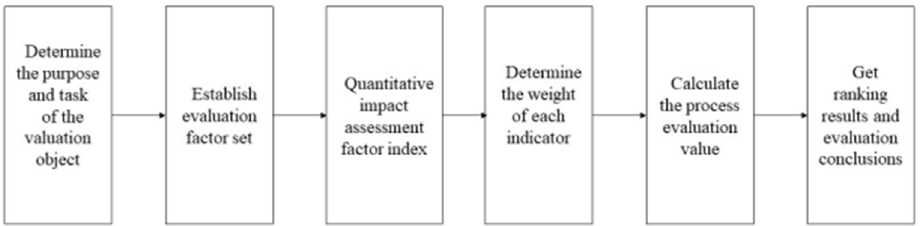
Figure 5. Multifactor weighted evaluation flow.